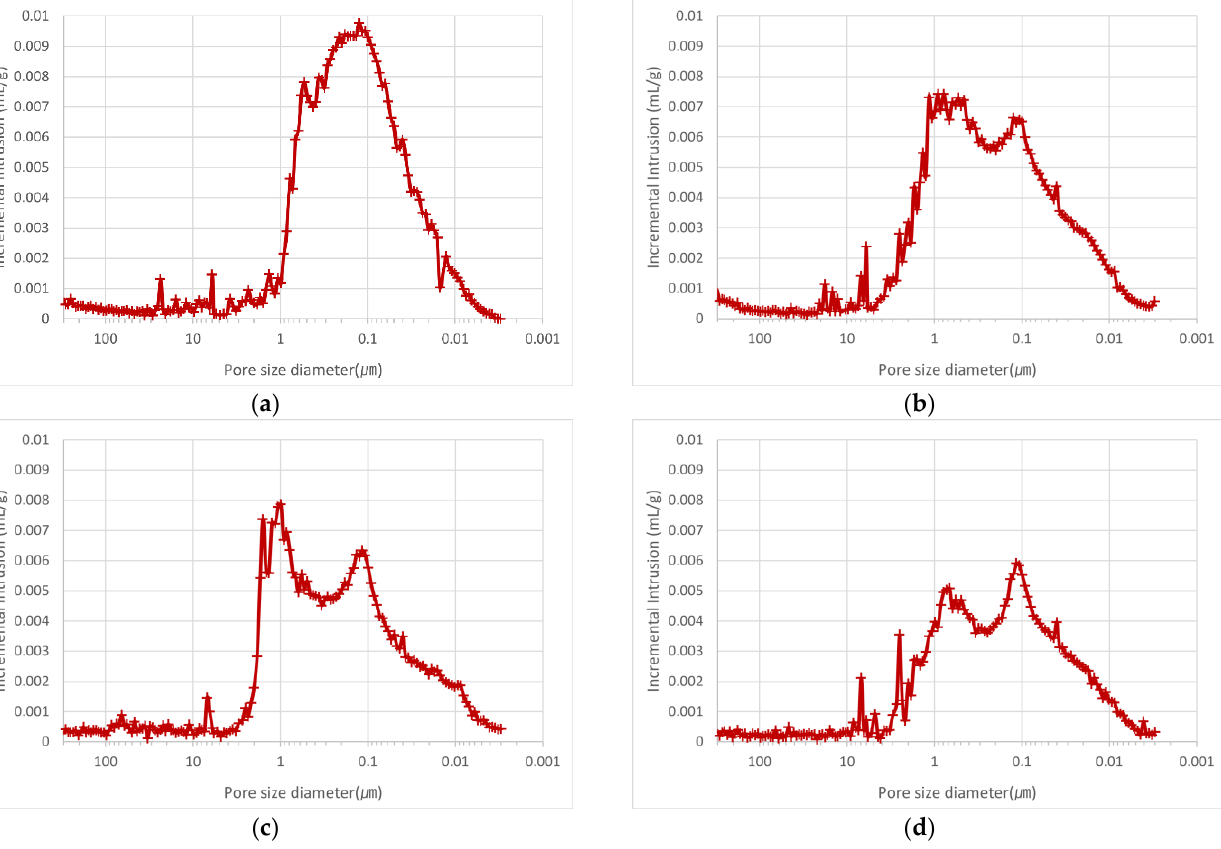
Figure 10. MIP measurement results: ( a ) MIP of O0.6U-M; ( b ) MIP of O0.6~1.2-M; ( c ) MIP of O1.2~2.5-M; ( d ) MIP of O2.5~2.5-M.